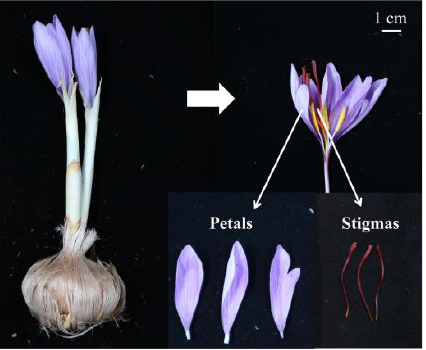
Figure 1. The stigmas and petals of saffron ( Crocus sativus L.).